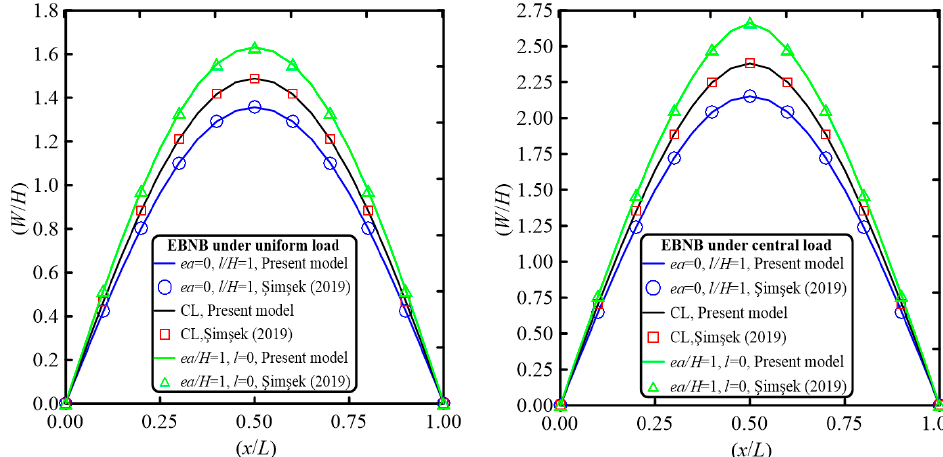
Figure 2. Comparison of the nondimensional bending profiles with the normalized axial coordinate for EBNB under uniformly distributed and central loading conditions for both classical and nonclassical analyses ( α = 1, P 0 = 50 nN, Q = 1 N/m, k w = k p = 0).